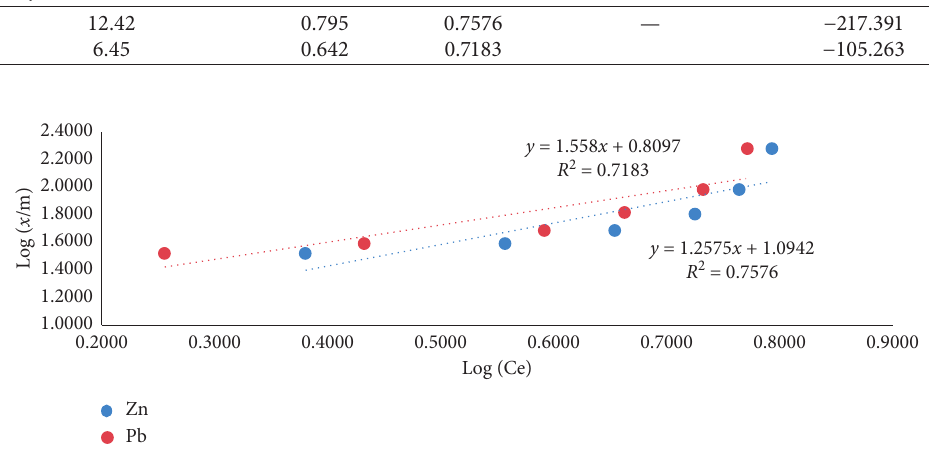
Figure 11: Freundlich isotherm of ZSM-11 on Pb 2+ and Zn 2+ removal from aqueous solution.